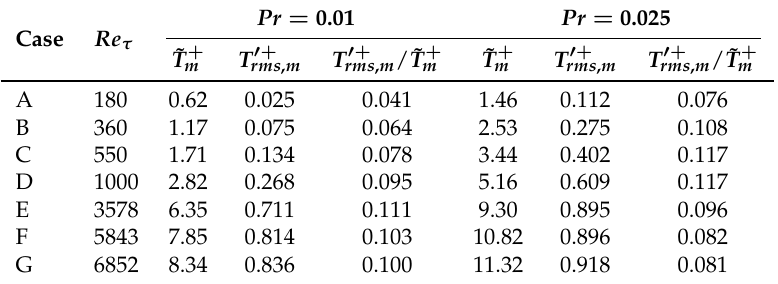
Table 8. Cylindrical pipe tests. Mean values across the transverse section of the pipe: RMS